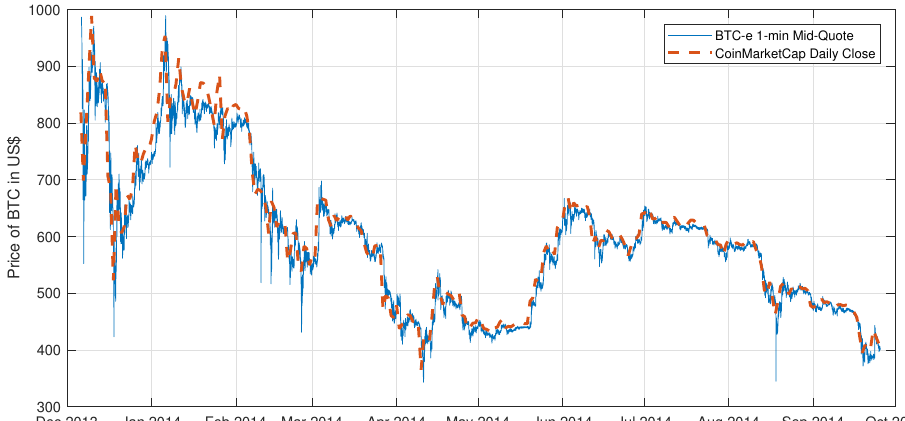
Figure 1. Evolution of bitcoin price on bitcoin exchange (BTC-e) versus other exchanges over sample period.